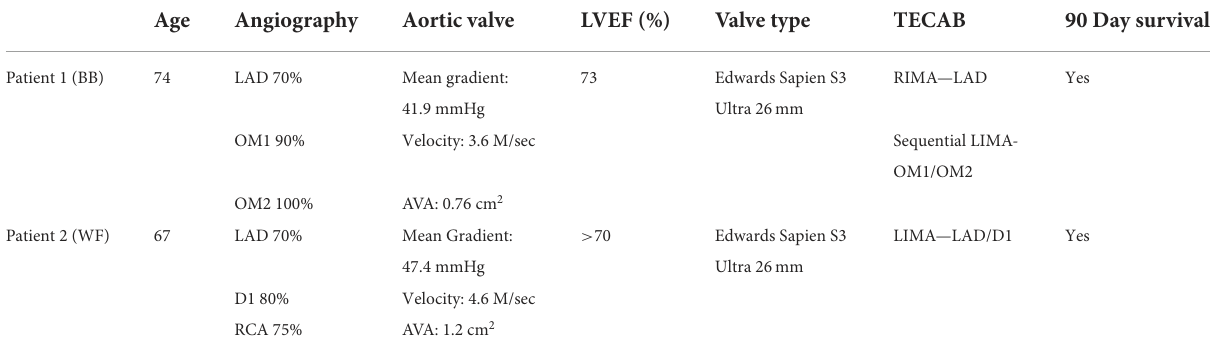
TABLE 2 Summary of